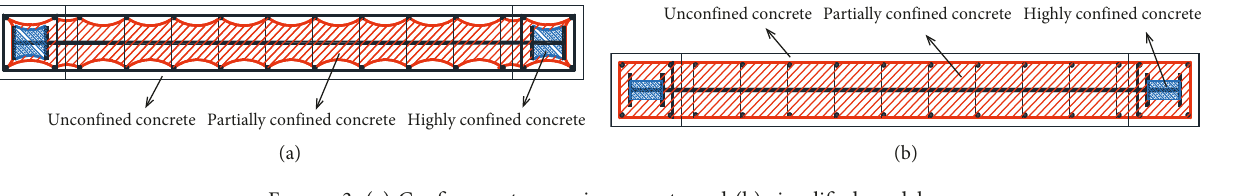
Figure 3: (a) Confinement zones in concrete and (b) simplified